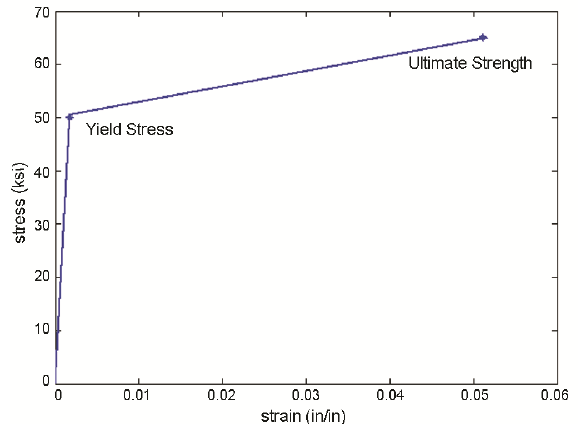
Fig. 6. Idealized stress and strain curve for steel (1 ksi = 6.9 MPa, 1 in= 25.4 m)